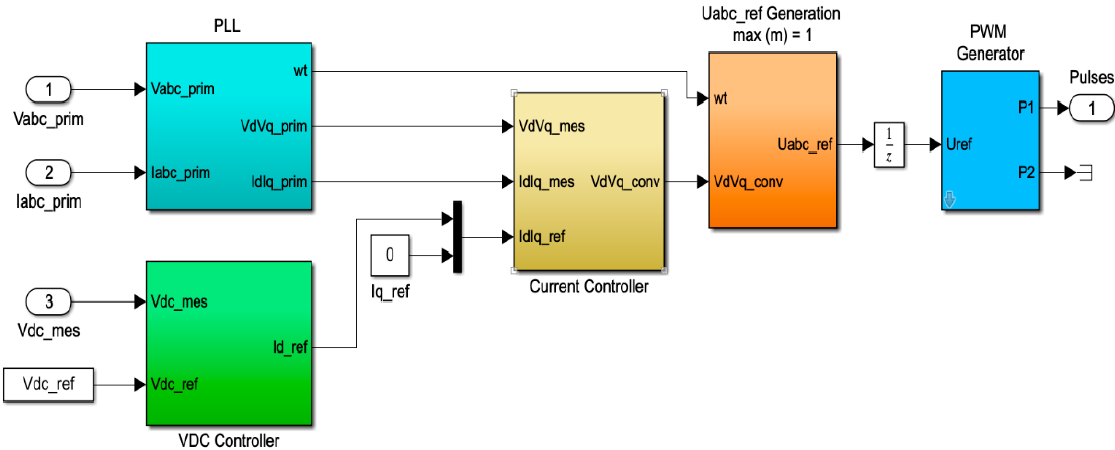
Figure 8. Model for VSC control.